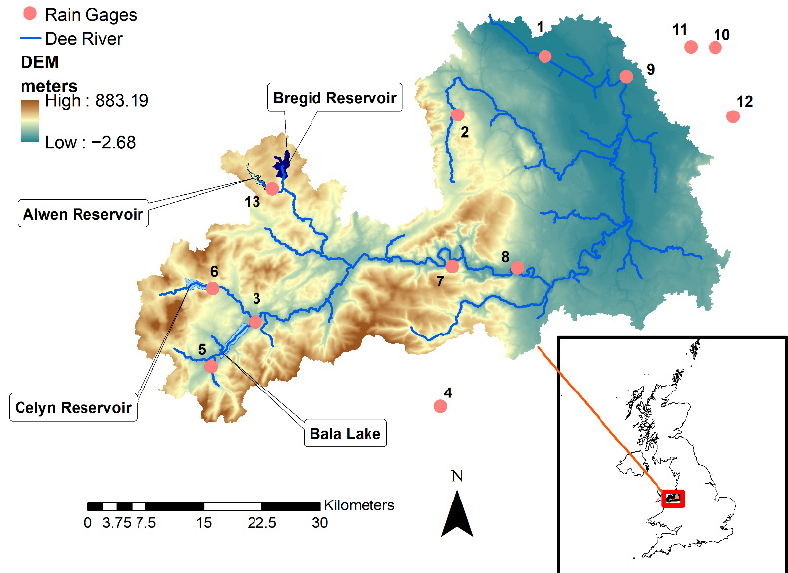
Figure 1. River Dee catchment location.